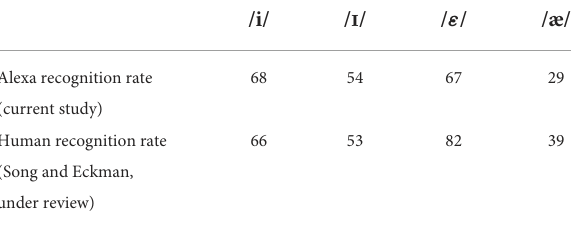
TABLE 4 Comparison of recognition rates by Alexa and human listeners. /i/ / I / / ε /